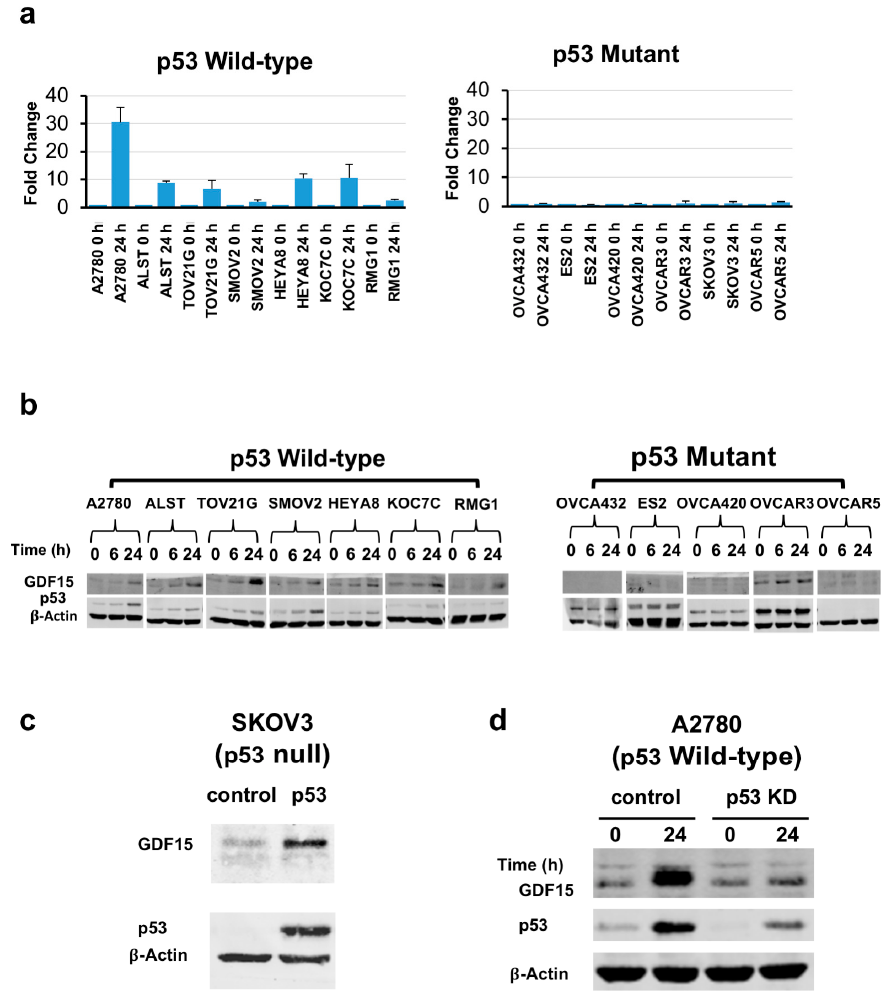
Figure 2. Induction of GDF15 expression in ovarian cancer cell lines after treatment with cisplatin depends on the presence and induction of wild-type p53. Cell lines with wild-type p53 or mutant p53 were treated with cisplatin at IC90 dose for 24 h (2.5 µ M: A2780, OVCA432; 5 µ M: ALST, OVCAR3, OVCA420, TOV21G, SMOV2; 10 µ M: ES2, HEYA8, KOC7C, OVCAR5, RMG1,